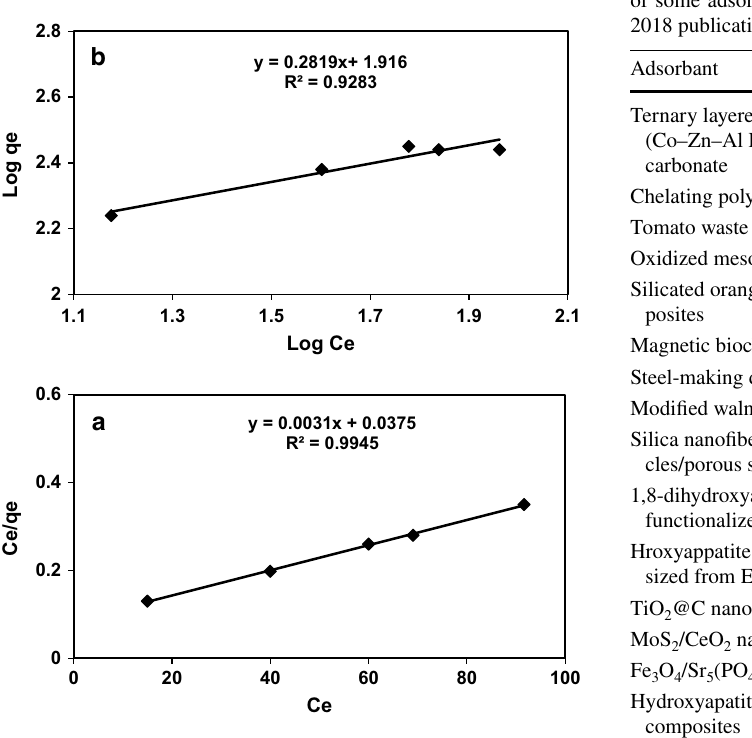
Table 2 Comparative values of maximum adsorption capacity ( Q